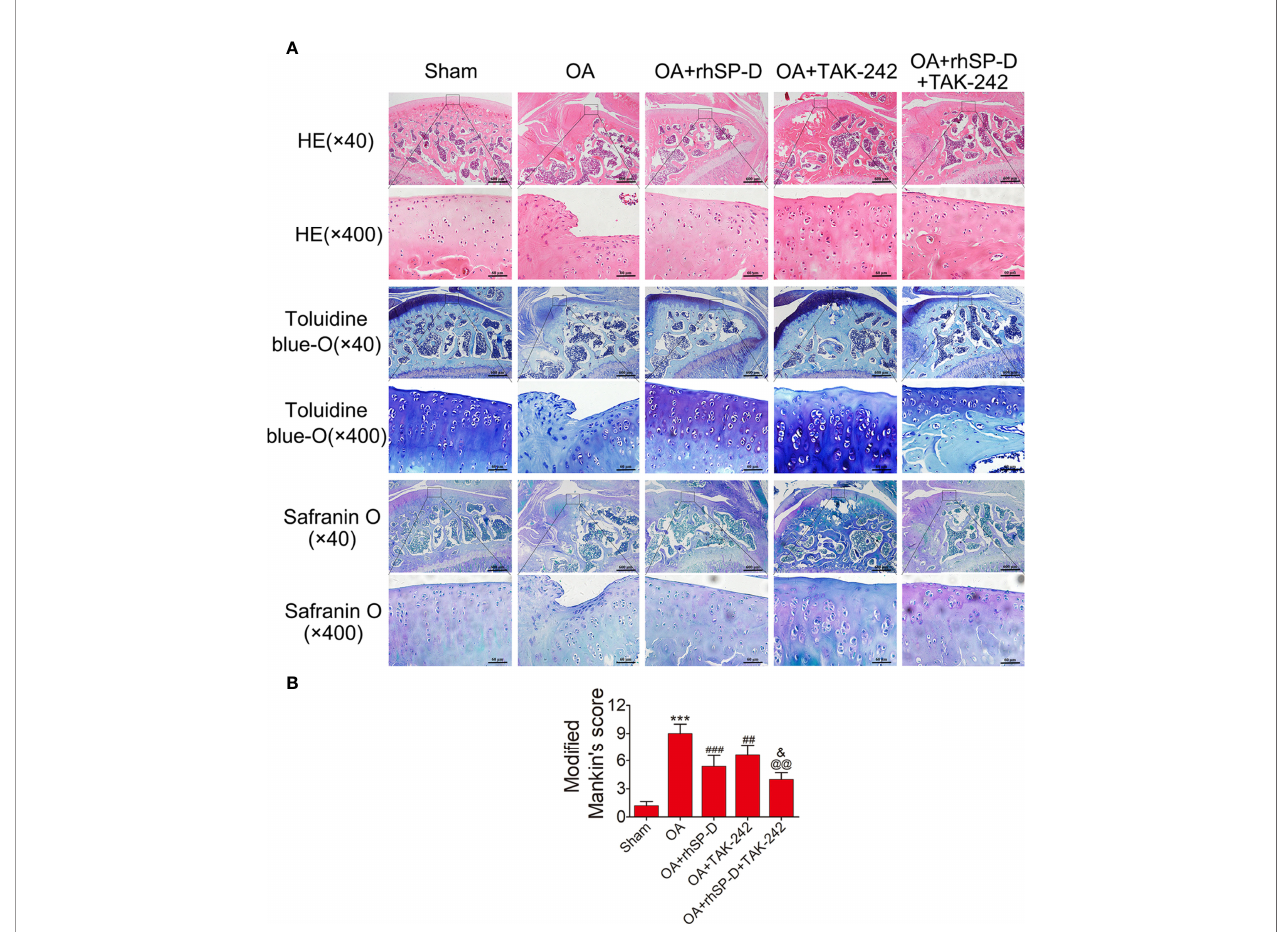
FIGURE 4 | The rescue of cartilage degeneration by SP-D in rat OA model. (A) H&E, Safranin O and toluidine blue O-stained tissue histology in rat articular cartilage at 10 weeks post-surgery. (B) The modi fi ed Mankin scores were assigned to tissue samples. Data were expressed as mean ± SEM (n = 5). ***P < 0.001 vs. the sham- operated group; ## P < 0.01 and ### P < 0.001 vs. the OA-induction group; & P < 0.05 vs. OA + rhSP-D group; @@ P < 0.01. vs. OA + TAK-242